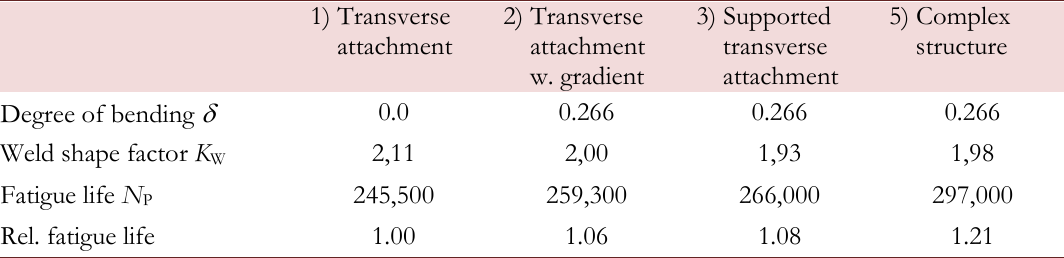
Table 4: Computed fatigue life N p for the same effective notch stress σ eff = 425 MPa at Detail